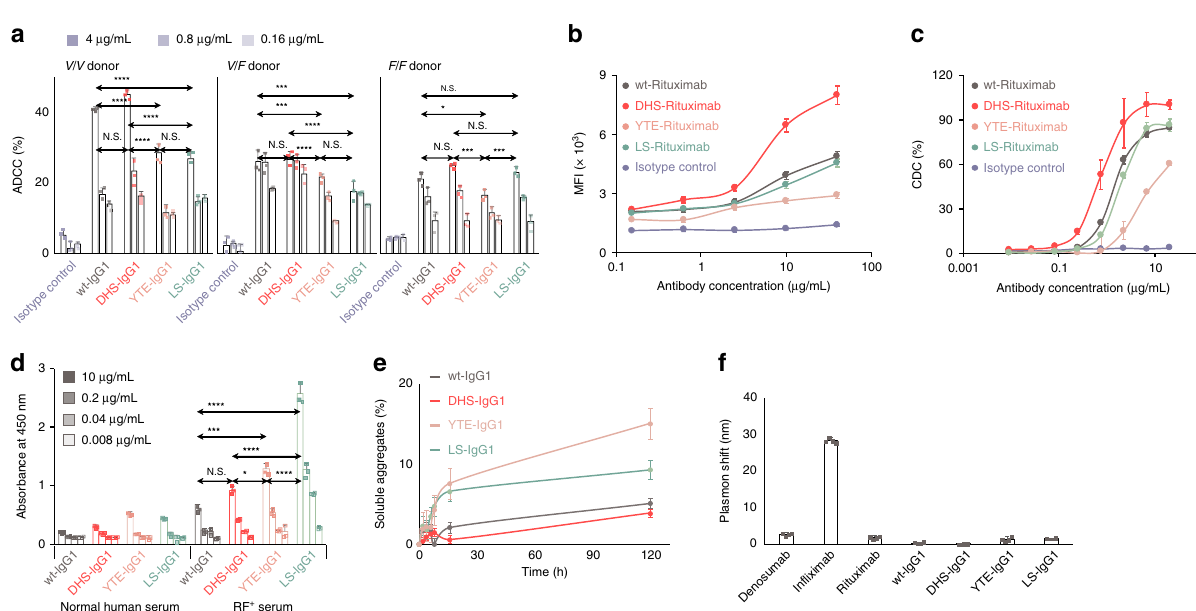
Fig. 3 Features of DHS Fc variants relevant to therapeutic antibody development. a ADCC assay of SK-BR-3 with PBMCs from Fc γ RIIIa V/V , V/F , or F/F donors. b C1q deposition on CD20 + Raji cells revealed by fl ow cytometry. c CDC assay of Rituximab-Fc variants with Raji cells as a function of antibody concentration. d Binding to rheumatoid factor (RF) measured by ELISA. P values by two-way ANOVA test, NS P ≥ 0.05, * P ≤ 0.05, ** P ≤ 0.01, *** P ≤ 0.001, and **** P ≤ 0.0001. e Extent of antibody aggregation following thermal stress (50°C incubation) of Trastuzumab variants, measured by size exclusion chromatography (SEC). f Antibody self-association properties measured by af fi nity-capture self-interaction nanoparticle spectroscopy (AC-SINS) assay. Data are from one experiment representative of three experiments using three individual donors ( a – d ). Errors in all plots and tables represent standard deviations from triplicate experiments